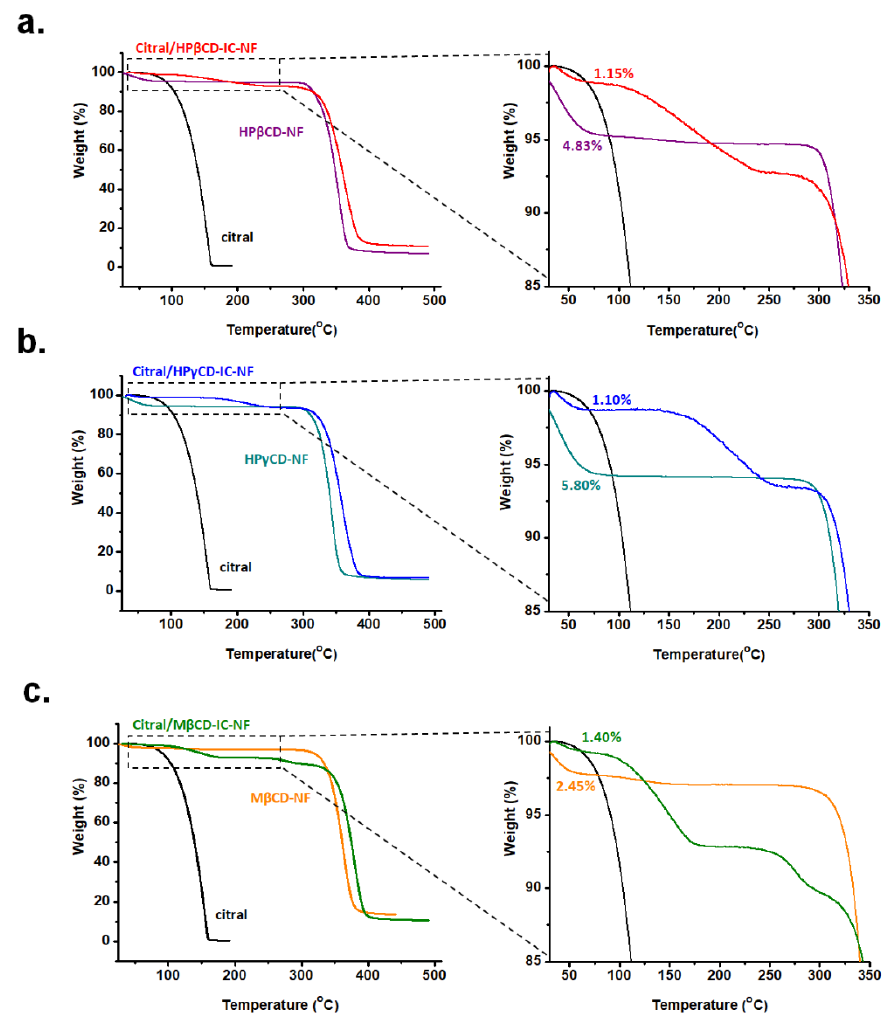
Figure 6. Thermogravimetric analysis (TGA) thermograms of ( a ) citral, HPβCD-NF, citral/HPβCD- IC-NF, ( b ) citral, HPγCD-NF, citral/HPγCD-IC-NF, and ( c ) citral, MβCD-NF, citral/MβCD-IC-NF. ( b ) citral, HP γ CD-NF, citral/HP γ CD-IC-NF, and ( c ) citral, M β CD-NF, citral/M β